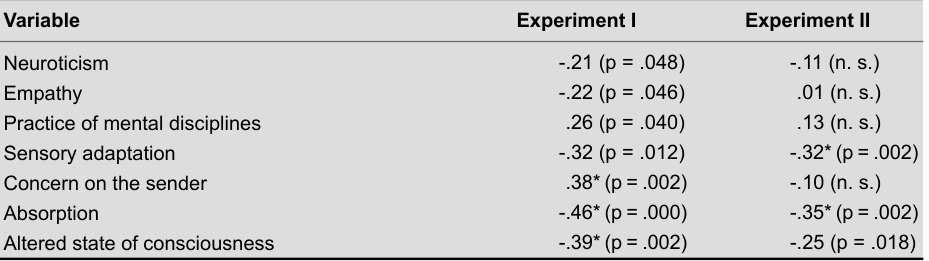
Correlation Coefficients and p-Values (< .05) of ESP Predictors in Experiments I and